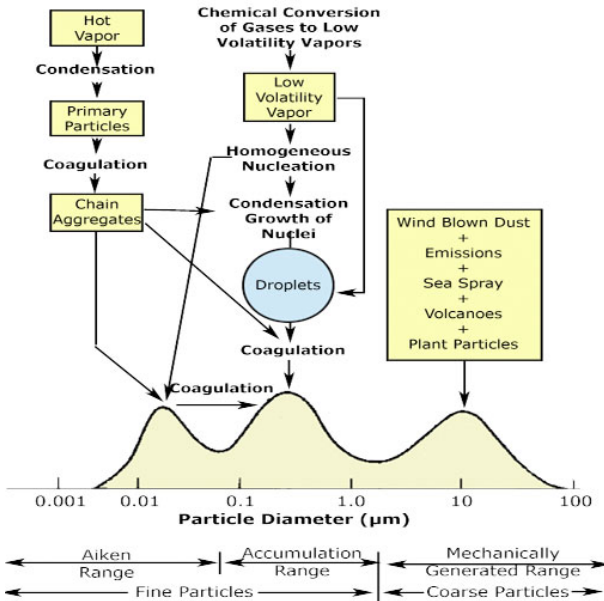
Figure 3. Schematic of atmospheric aerosol particle size dis- tribution showing the three modes, the main source of mass for each mode, and the principal processes involved in in- serting mass to each mode along with the principal removal mechanisms (Whitby, 1978) (taken from